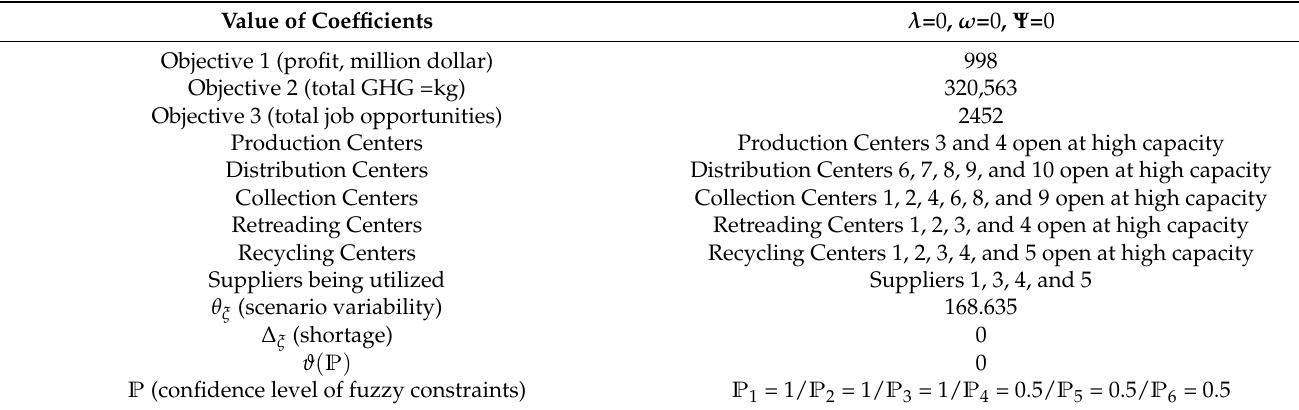
Table 10. Summary of optimum result (maximizing the social